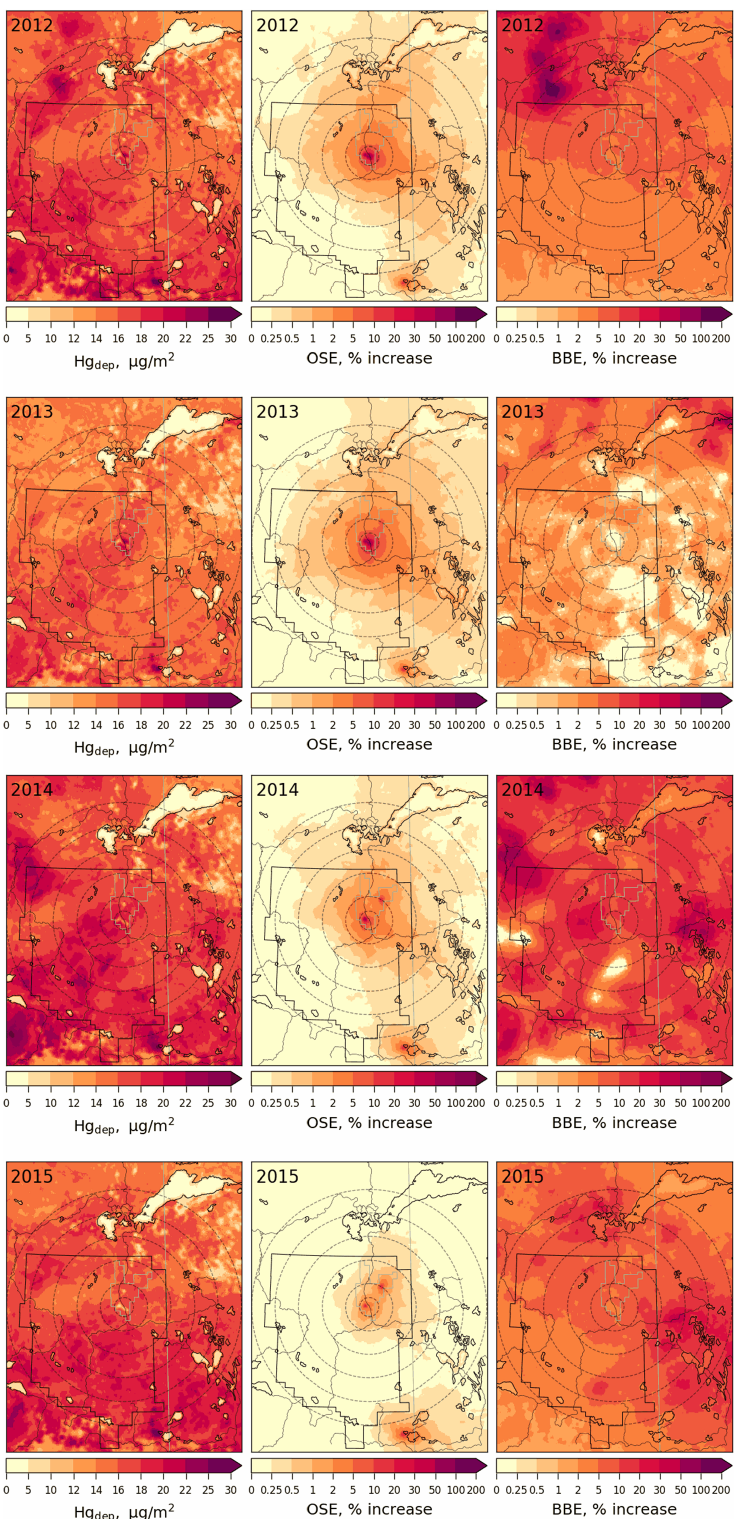
Figure 14. Annual total Hg deposition flux (left) and deposition enrichments (%) due to Hg emissions from Athabasca oil sands operations (OSE, middle) and biomass burning in North America (BBE, right) in 2012–2015. The AOSR is marked as an approximate rectangle, and concentric distance circles are at 20, 50, 100, 150, 200 and 250km from